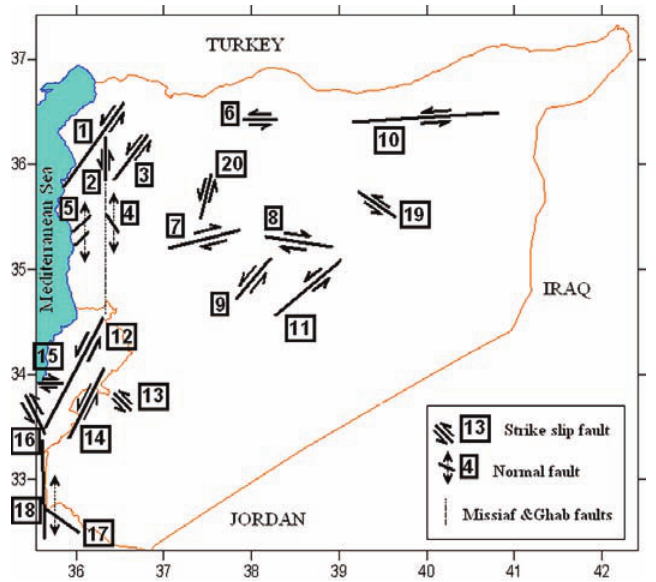
Figure 5. Simplified interpretation of the focal mechanisms over the last decade for the largest events in Syria. The active faults proposed to be generating these events were: 1, East Anatolian Fault System; 2, Northern section of the Dead Sea Transform System; 3, Rouge Faults; 4, Normal faults in the Al-Ghab pull-apart basin; 5, Normal faults in the coastal ranges; 6, Manbeg Fault; 7, Al-Sa'an Fault; 8, Dextral fault separating the Bilas-Bishri Blocs; 9, Bilas Bloc Faults; 10, Abdel-Aziz uplift Faults; 11, Palmyra Faults; 12, Yammouneh Fault; 13, Ma'alola Fault; 14, Serghaya Fault; 15, Dextral fault in the north of Beirut; 16, Roum Fault; 17, Normal faults on the margins of the DSFS; 18, The DSFS; 19, Bishri Faults; 20, Khanaser